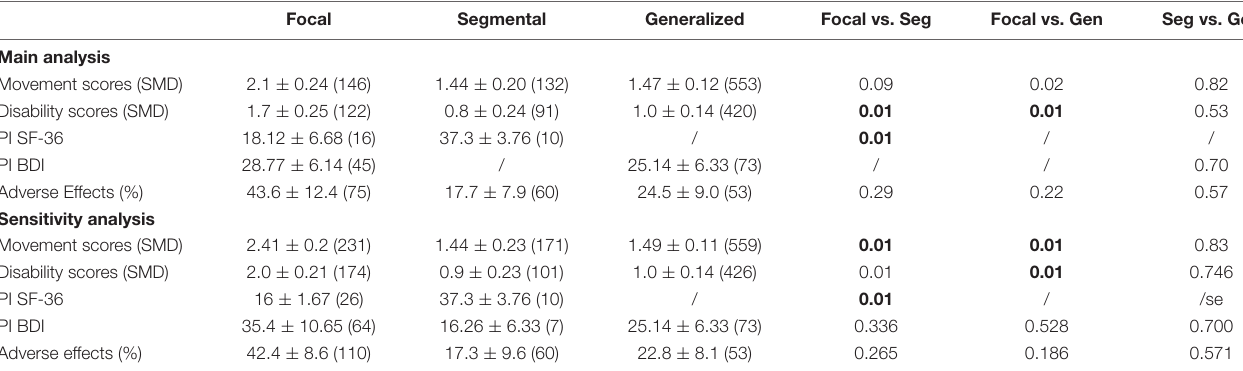
TABLE 3 | The main and sensitivity analyses of the efficacy, quality of life and adverse effects after DBS in the body distribution subgroup a